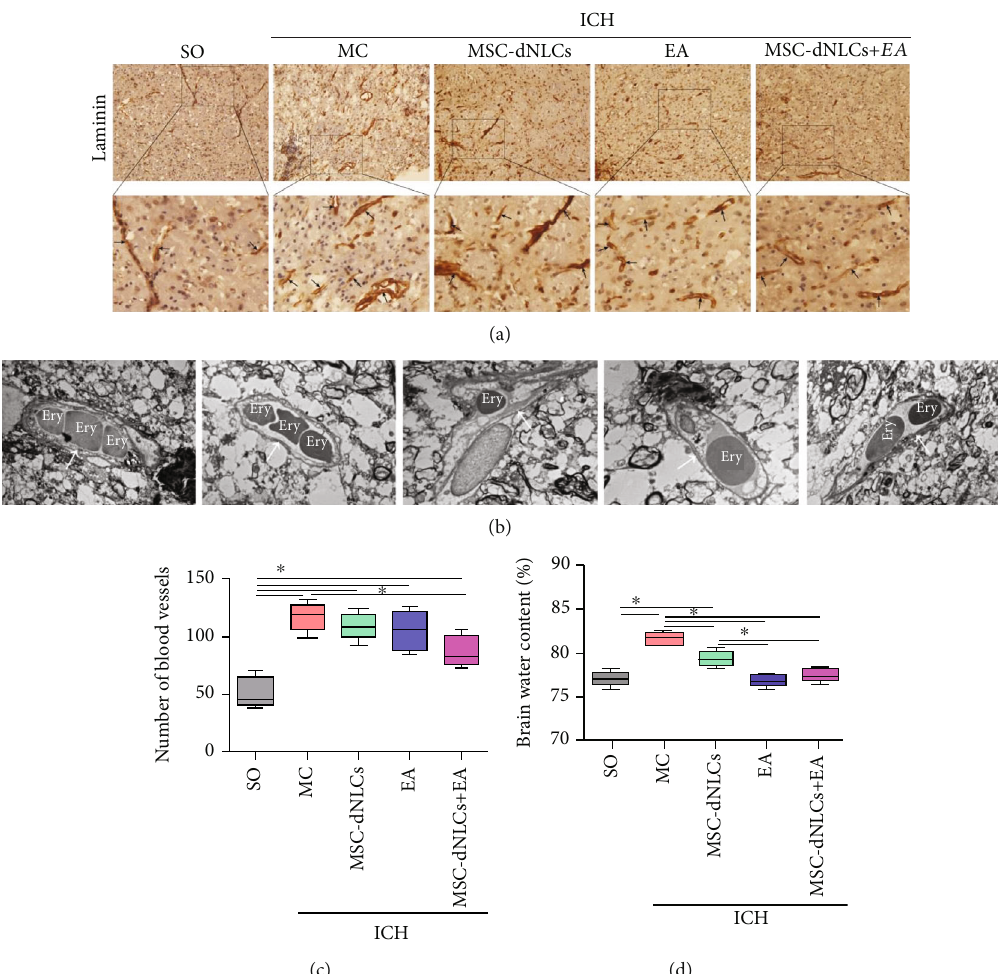
Figure 3: The combined treatment reduced the number of blood vessels and attenuated brain edema in rats with ICH. (a) Images of laminin immunohistochemistry in the ipsilateral striatum of rats. The black arrows show blood vessels. Scale bar = 100 μ m . (b) Electron photomicrographs of blood vessels in the peripheral area of hemorrhagic foci. The white arrows show capillaries, and ery indicates erythrocytes. Scale bar = 5 μ m . (c) The number of blood vessels in di ff erent groups ( n = 5 rats per group; ∗ P < 0 : 05 ). (d) The brain water content of brain samples from di ff erent groups ( n = 5 rats per group; ∗ P < 0 : 05